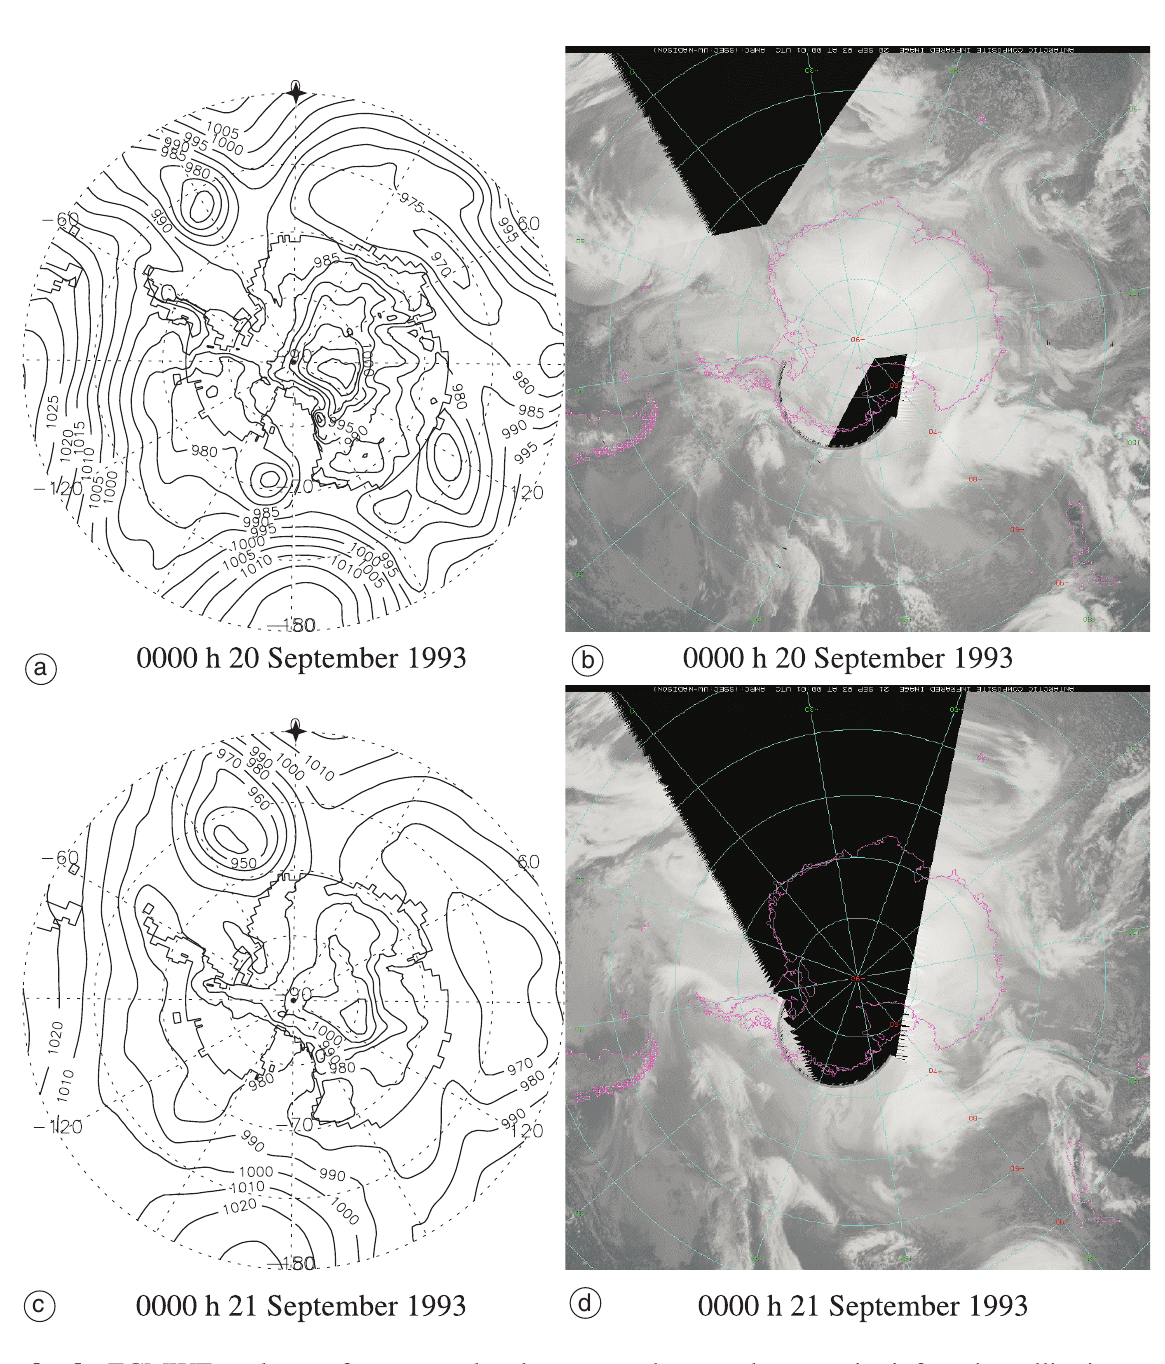
Fig. 9a-d. ECMWF analyses of mean sea level pressure charts and composite infrared satellite images for 0000 h 20 September (a,b) and 0000 h 21 September 1993 (c,d),